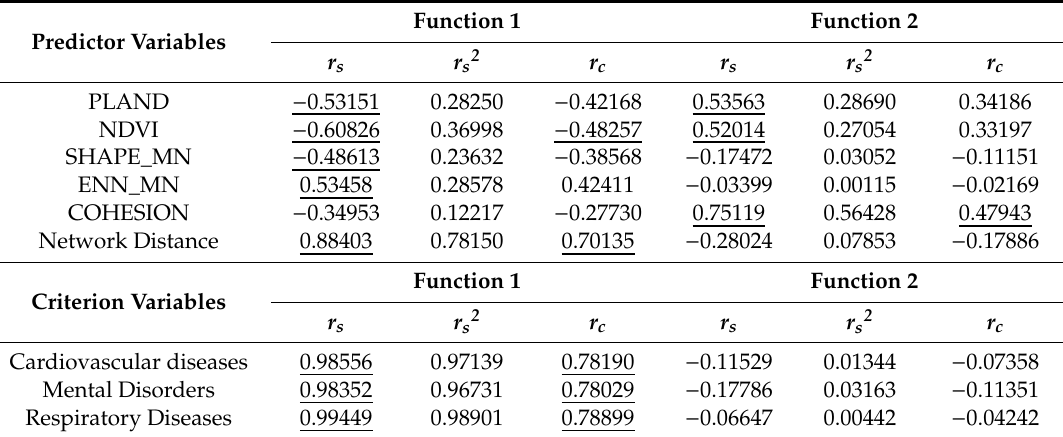
Table 7. Canonical correlation